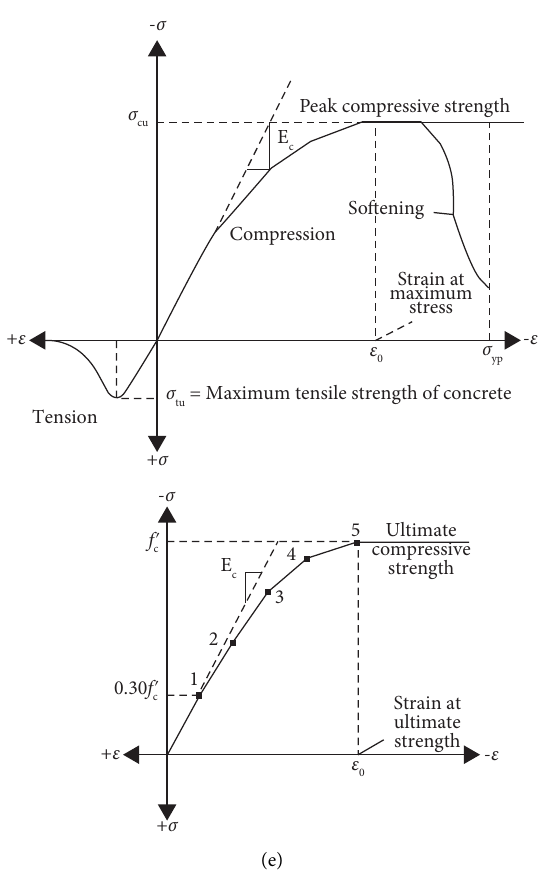
Figure 5: ANSYS model of a beam constructed with two layers of concrete: (a) a model of a beam made of double-layered concrete; (b) the model of the steel bars including the boundary condition and the load; (c) steel fber model in concrete [25]; (d) concrete cracking model [25]; (e) typical uniaxial compressive and tensile stress-strain curve for concrete